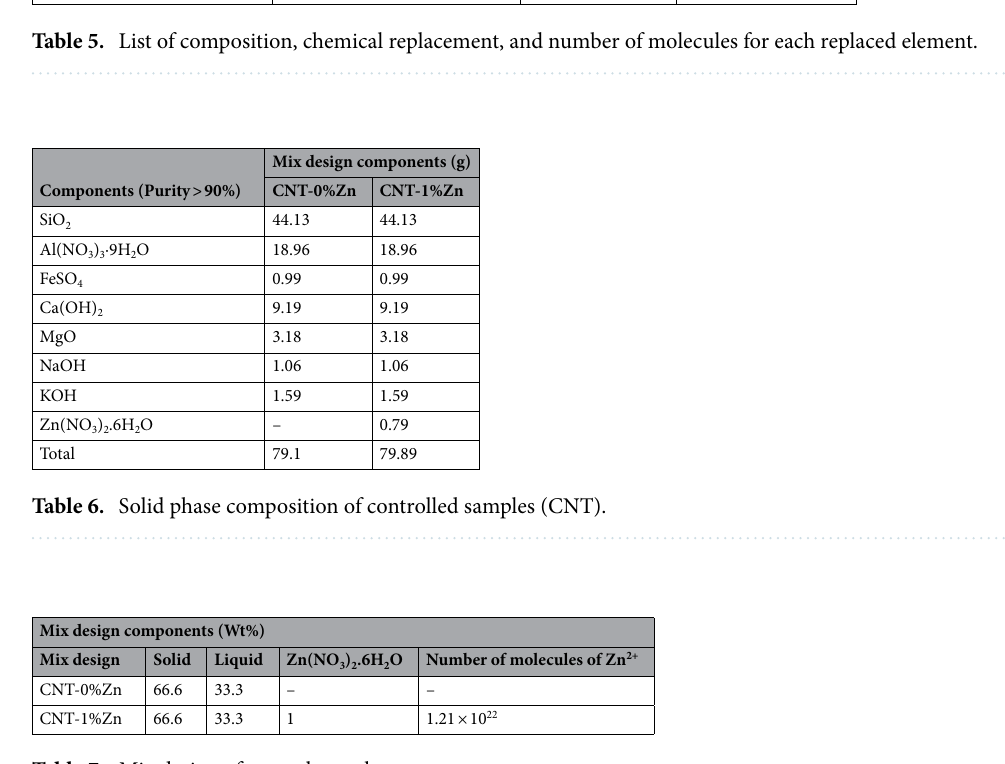
Table 7. Mix design of control samples.